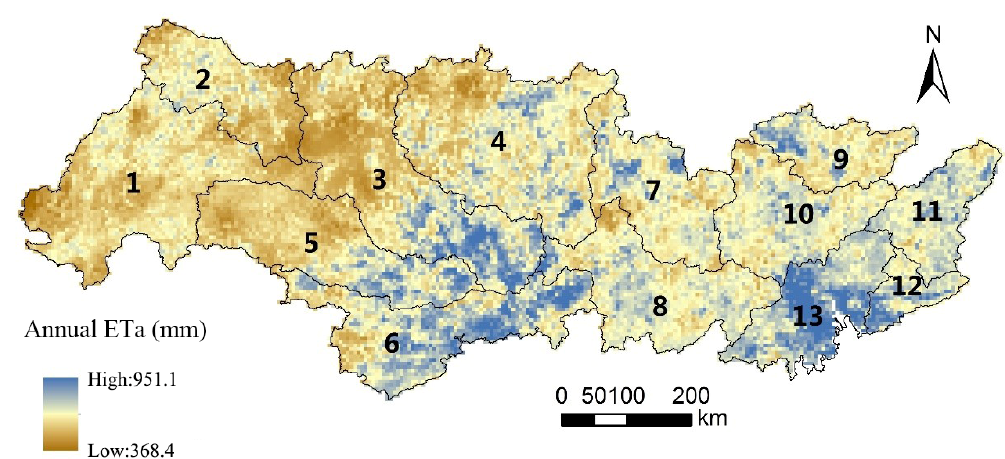
Figure 3. Annual ETa of the Pearl River Basin during 1960–2014 ( α = 0.05).